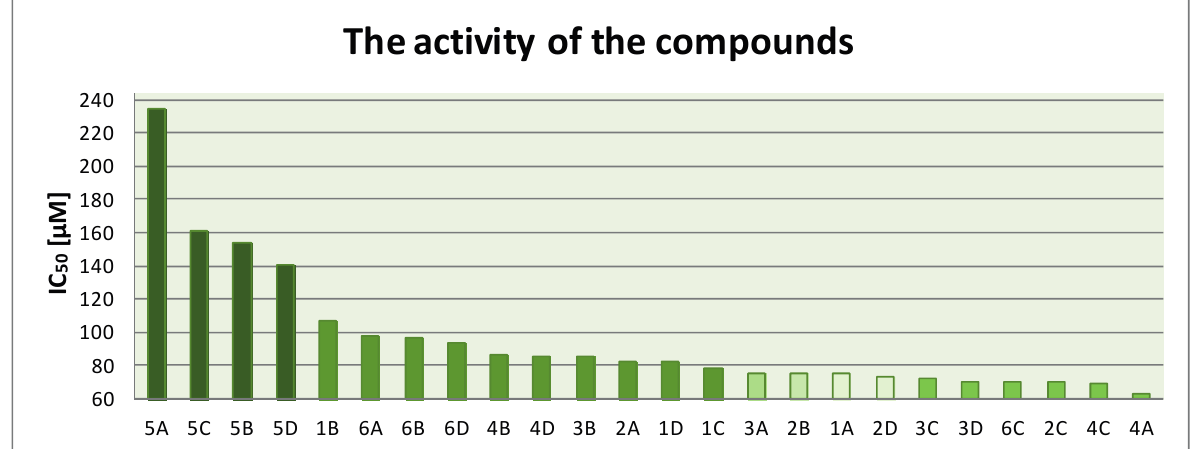
values of compounds 1 – 24 . 50